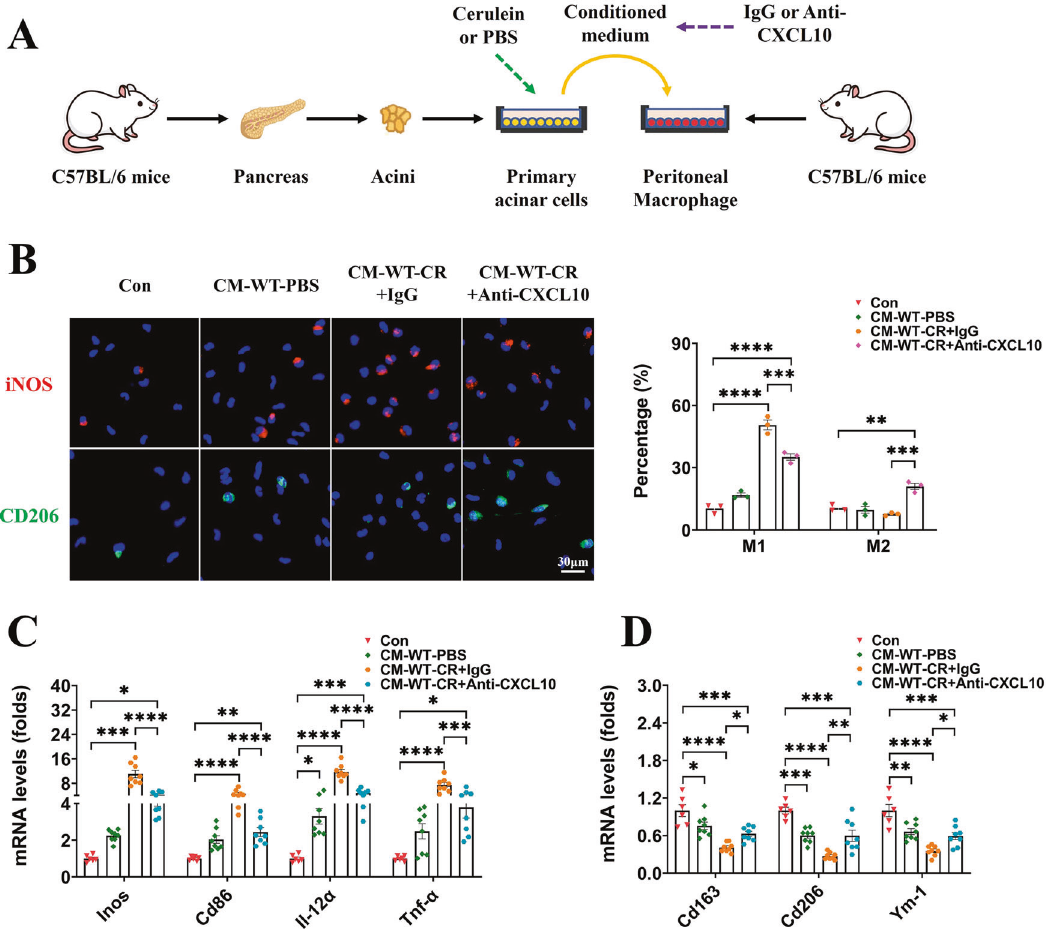
Fig. 7 Rabbit anti-mouse CXCL10 neutralizing antibody (2 μ g/mL) was added to the conditioned medium from WT mouse-derived, cerulein-treated pancreatic acinar cells. Rabbit IgG was added as an isotype control, and neutralization of CXCL10 impaired its ability to promote macrophage polarization toward M1. A Schematic diagram of constructing an indirect coculture system and preparing conditioned medium with CXCL10 neutralization. B Immuno fl uorescence staining of iNOS (red) and CD206 (green) in peritoneal macrophages ( n = 3). C , D mRNA levels of M1 macrophage markers ( Inos, Cd86, Il-12a, Tnf- α ) and M2 macrophage markers ( Cd163, Cd206, Ym-1 ) in peritoneal macrophages. Data were normalized to GAPDH ( n = 6 – 8). Values are shown as the means ± SEMs. ns, not signi fi cant; * P < 0.05; ** P < 0.01; *** P < 0.001; **** P < 0.0001. WT wild type, Con control, CR cerulein, CM conditioned